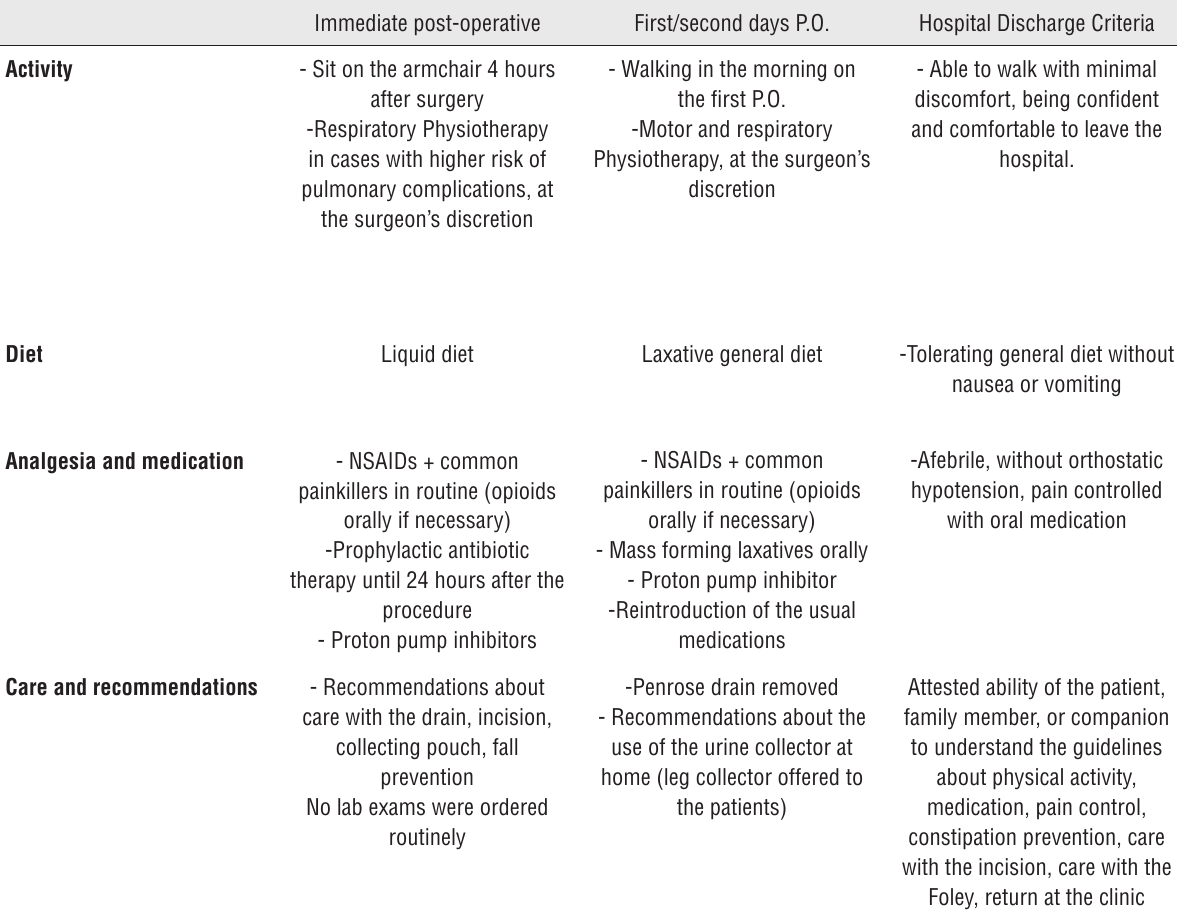
Table 1 - Peri-operative Care and Hospital Discharge Criteria. Immediate post-operative First/second days